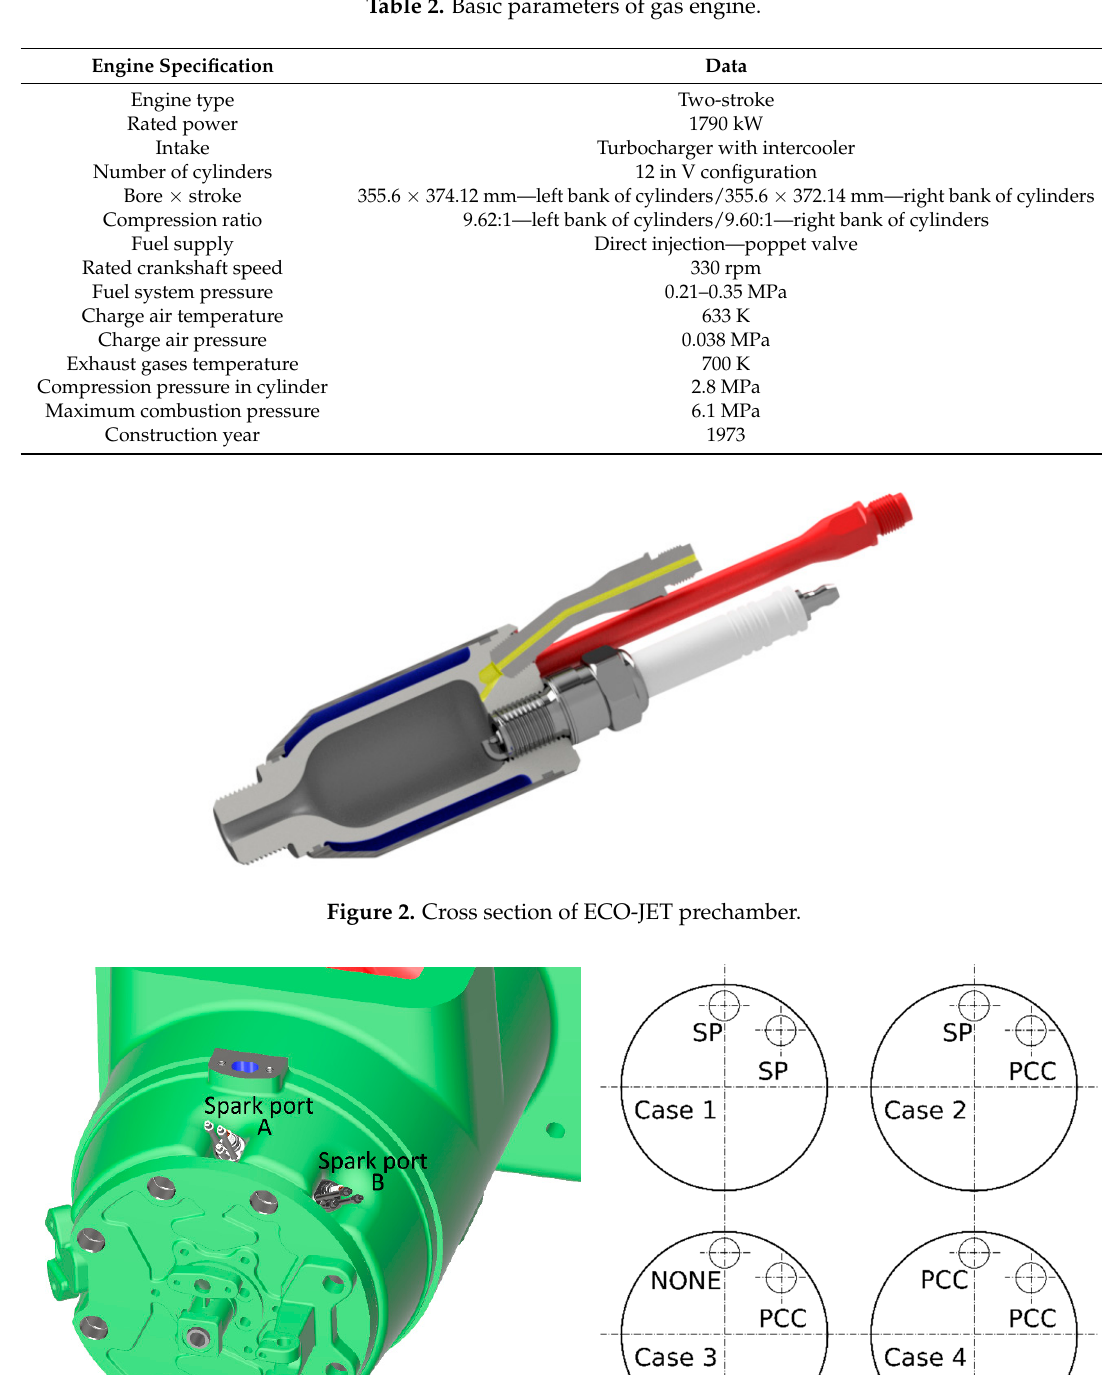
Table 2. Basic parameters of gas engine.